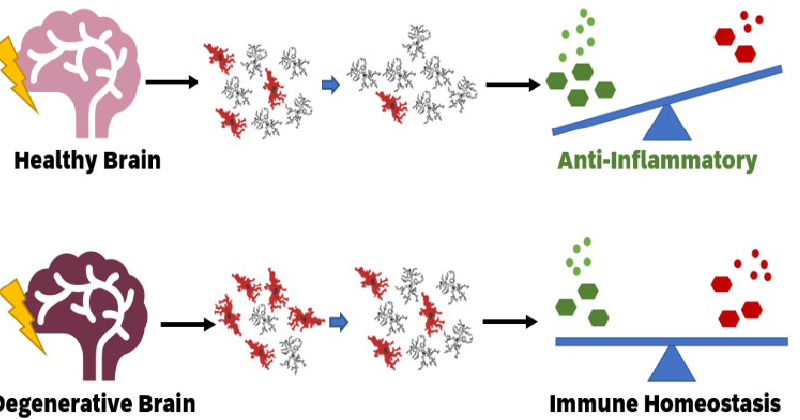
Figure 2. Low dose ionising radiation strengthens immunity in the healthy brain and reduces neu- rodegenerative disease by changing microglial functional states. A healthy brain exposed to low dose ionising radiation may experience anti-inflammatory effects, whereas in a degenerative brain, such as in Alzheimer’s disease, low dose ionising radiation may lessen the severity of neuroinflammation and promote a shift towards a more “normal” brain environment.